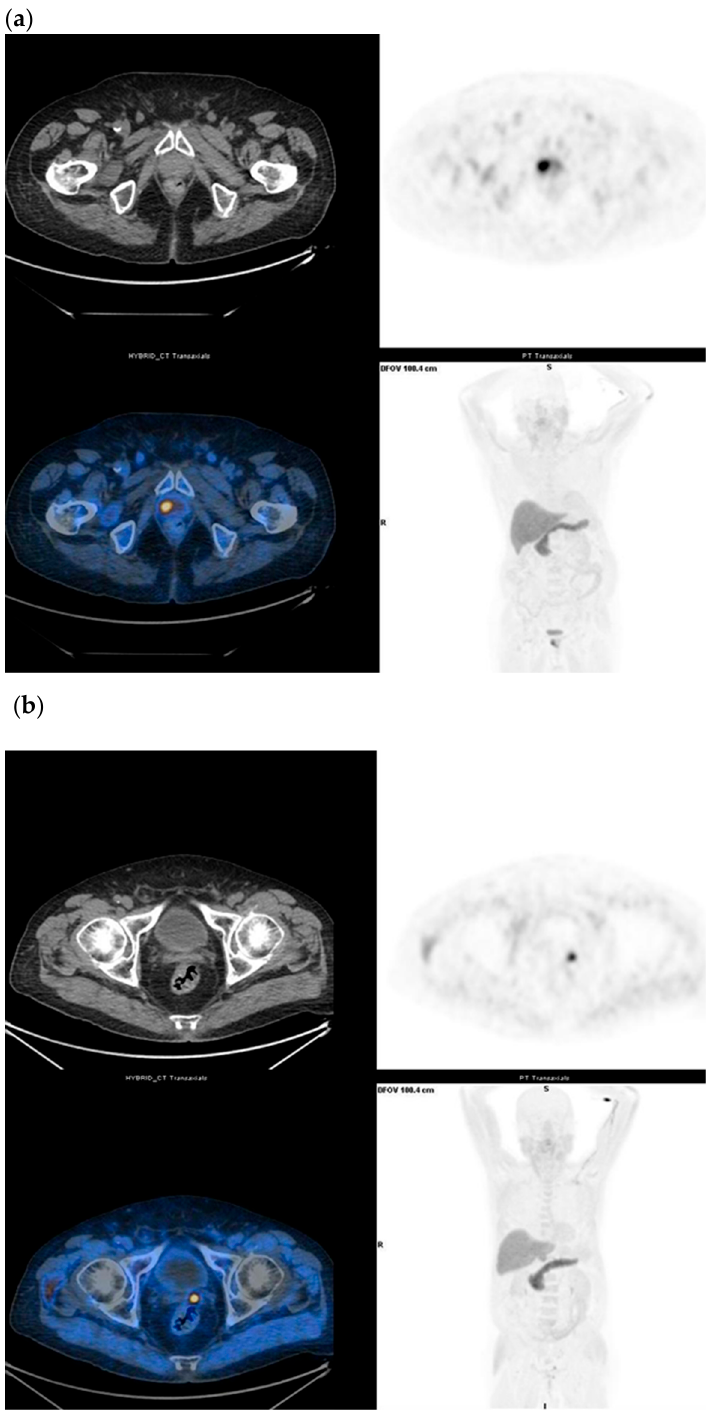
Figure 5. ( a ) Staging in un-operated prostate cancer under drug treatment (Gleason Score: 4 + 3) and with a moderate increase in serum PSA (1.67 ng/mL); 18F-Fluciclovine PET/CT shows intense parenchymal uptake (SUV max 15) in the right paramedian site of the prostate. ( b ) Biochemical recurrence in prostate cancer (Gleason Score: 4 + 4) subjected to radical HIFU treatment three years ago and with PSA elevation (3.3 ng / mL); 18F-Fluciclovine PET/CT shows a focal uptake in the left prostatic lodge (SUV max 7).